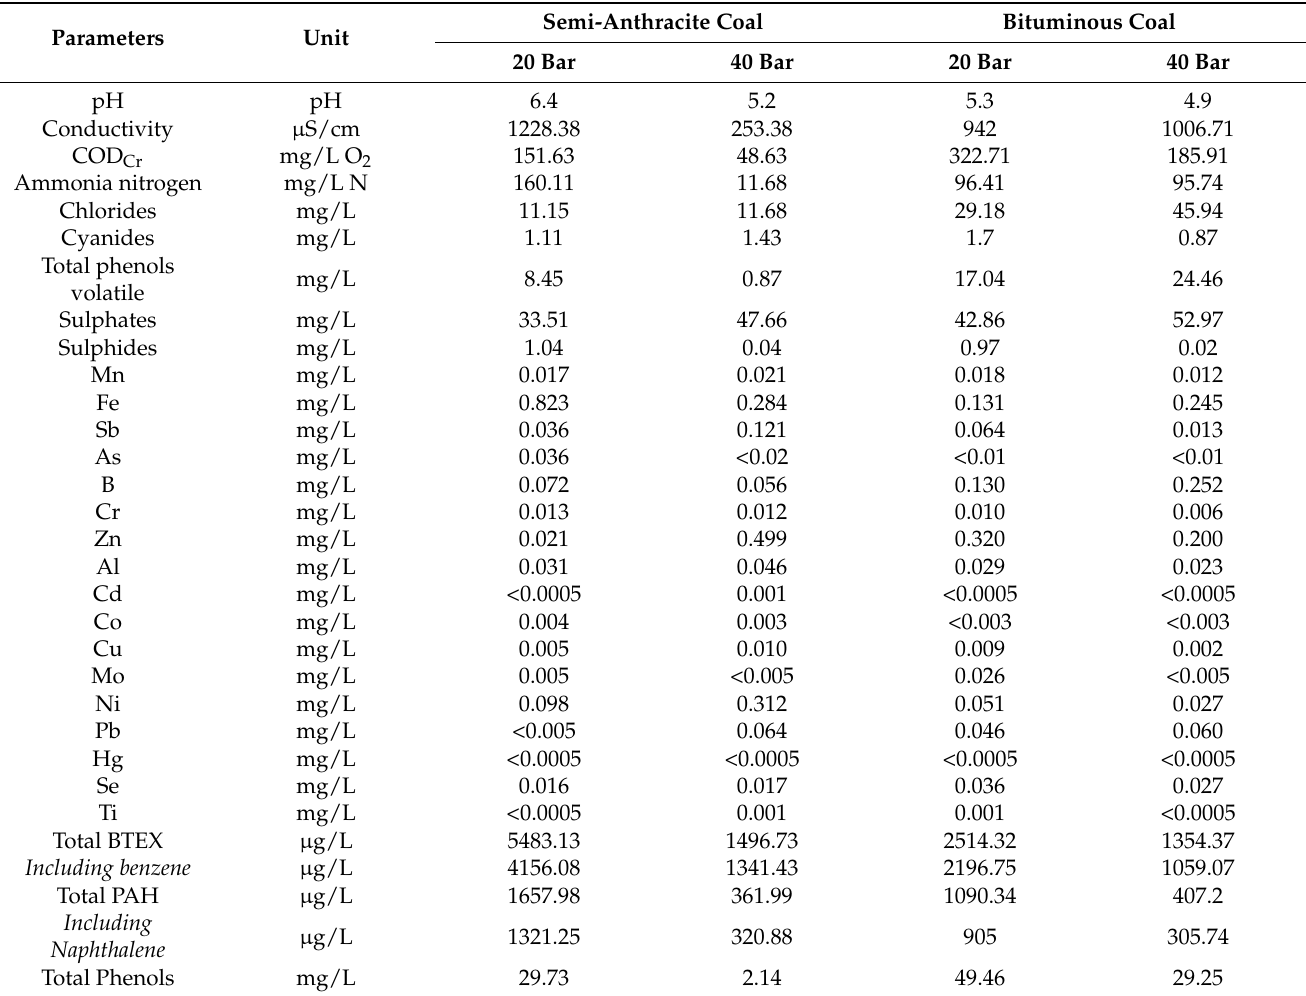
Table 4. Average values of physicochemical parameters determined in the UCG effluents from semi-anthracite and bituminous coal